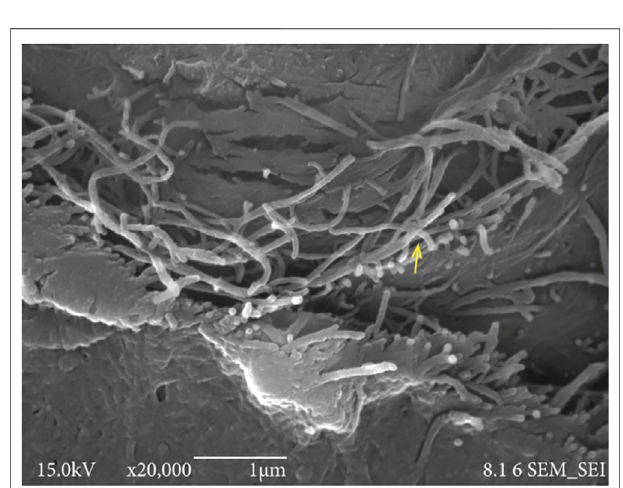
FIGURE3 | Bacterial cellulose fi ber used for obtaining cellulose particles for the lubricant additive.